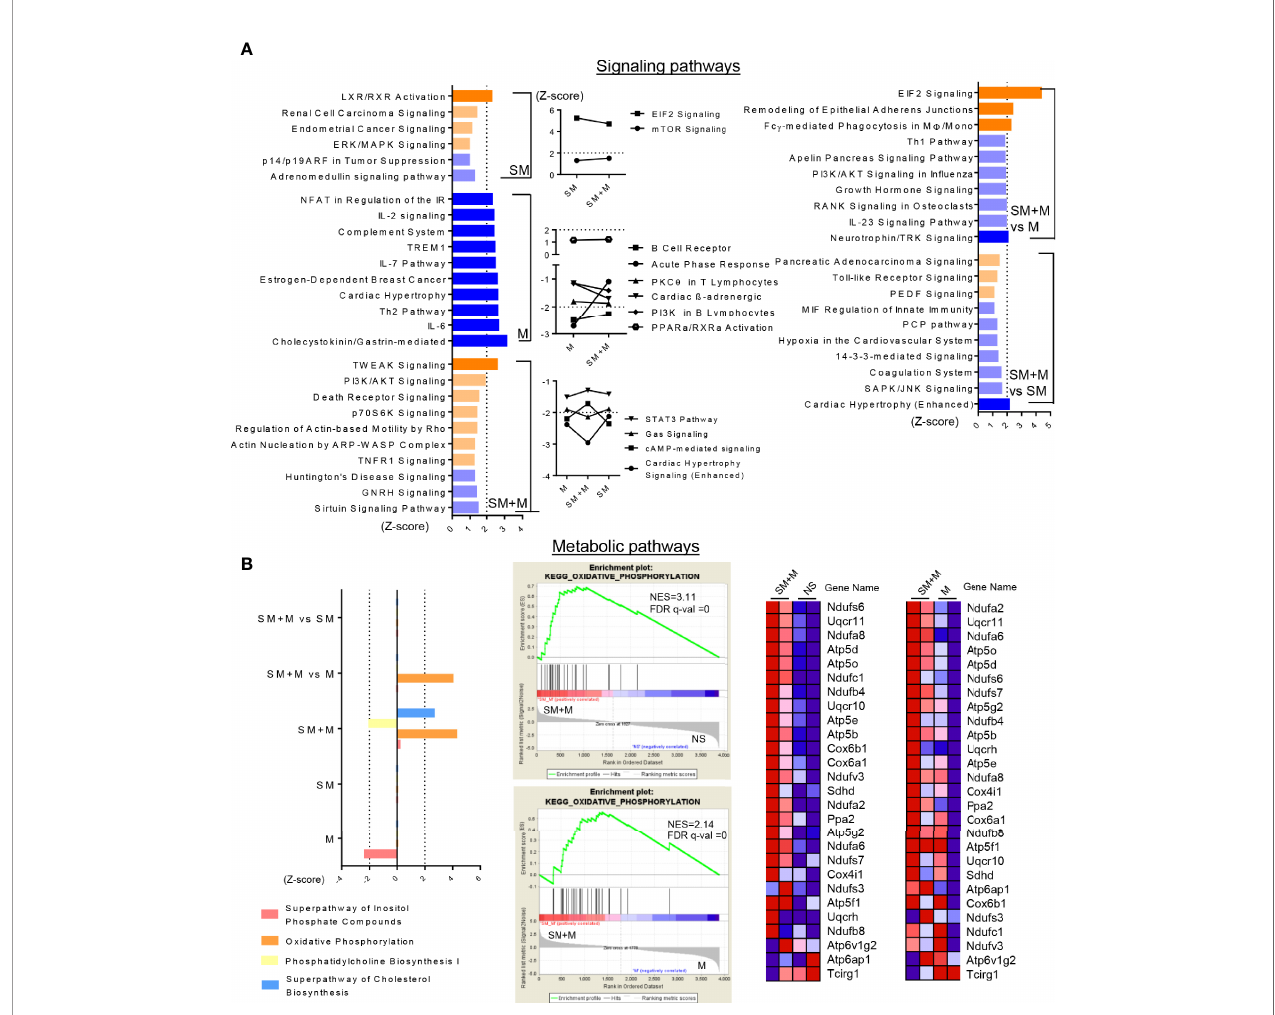
FIGURE 3 | SM + M have synergistic effects to activate TWEAK, PI3K/AKT and OXPHOS pathways on Treg cells. (A) Ingenuity Pathway Analysis (IPA) identify the signaling pathways based on the differentially expressed genes (with P value < 0.05) from each comparisons. Bar graph (left) show the top 10 pathways (ordered by |Z-score|) only modulated upon SM, M and SM + M treatment versus control (P value < 0.05, and |Z-score| ≥ 1 was set as cut-off in this study). Plot graph (middle) show overlapped pathways modulated in SM + M and SM or/and M. Bar graph (right) show top pathways modulated upon SM + M versus SM or M alone. Bar in dark orange (Z-score ≥ 2) represent activation of the pathway and in dark blue (Z-score ≤ -2) represent inhibition. (B) Ingenuity Pathway Analysis (left) identify the metabolic pathways modulated upon treatments. Gene set enrichment assay (GSEA, middle) also identify the expression dataset of SM + M are signi fi cantly enriched in the class of genes involved in KEGG OXPHOS pathway. Heatmaps on the right display the gene change associate with the activation of OXPHOS in SM + M when compared with NS or M alone. (NES, normalized enrichment score; FDR, false discovery